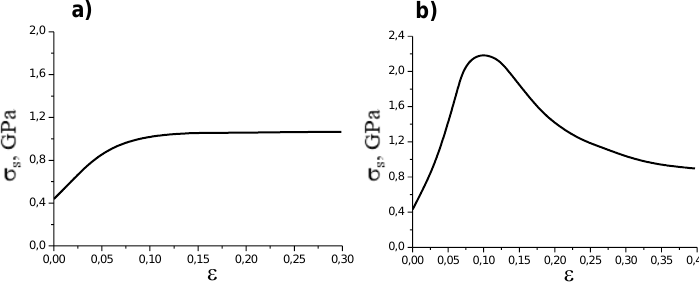
Fig. 3. Stress-strain curve of Ni 3 Al alloy obtained by solving the equations of the dislocation kinetics model for alloys with the L1 2